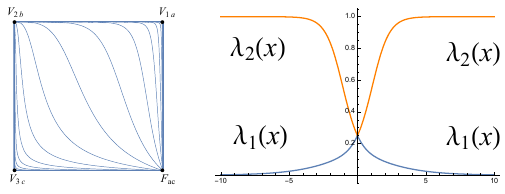
Figure 6 . Orbits for several members of the family K ( q;a;b;c ) (right) graphically represented in sphero-conical